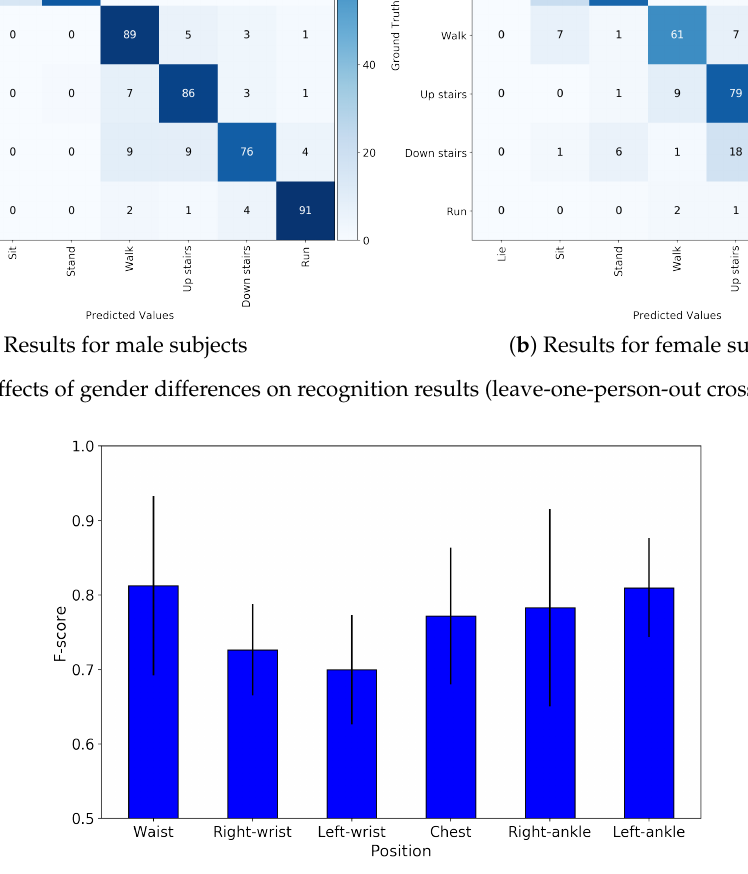
Figure 14. Difference in accuracy for each body